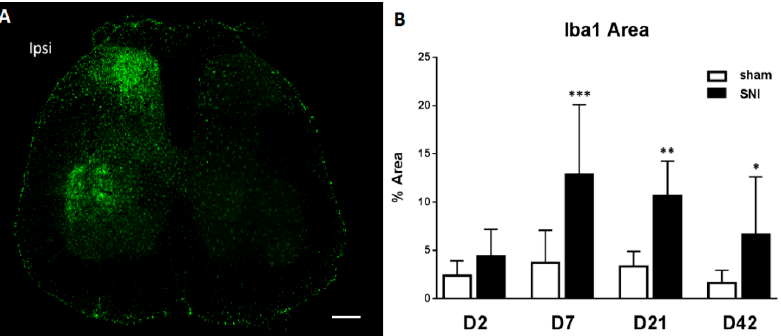
Figure 2. Neuroinflammation in the spinal cord after SNI. ( A ) Immunofluorescence of a lumbar section seven days after injury showing the microglial activation marker Iba1 in green ( B ) Time course of the percentage of Iba1 positive area by immunostaining in the ipsilateral dorsal horn. N = 4/group. Values are expressed as mean ± 95% CI, 2-way ANOVA with Sidak correction, sham vs . SNI. * p < 0.05, ** p < 0.01, *** p < 0.001. Scale bar represents 200 µm.